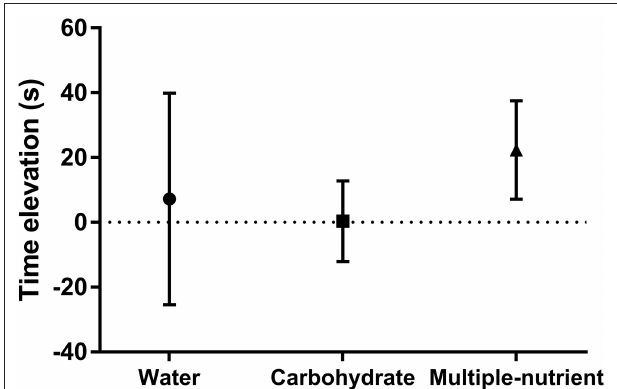
FIGURE 5 | Elevation of running time after 7 days of supplementation in the short-term supplement trial. Values are mean ± SEM.